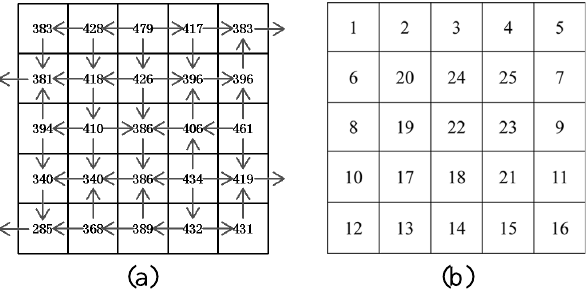
Fig. 5. DEM with depression removal algorithm applied and the relevant processing